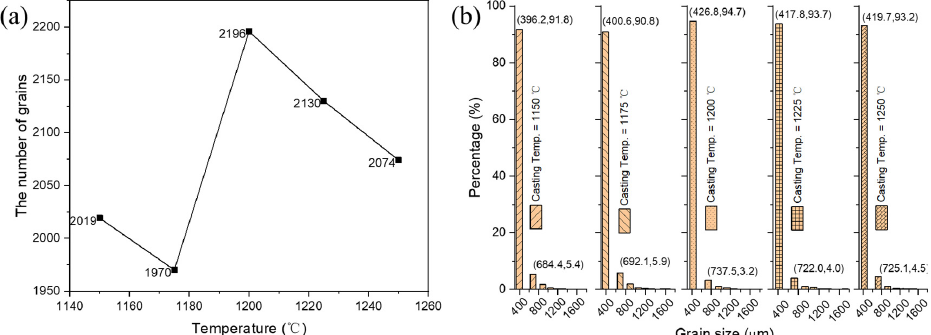
Figure 10. The number of grains and grain size distribution on the cross ‐ section of billet with different casting temperatures, where ( a ) is the variations of total grains numbers, and ( b ) is the percentage of grains of different sizes.